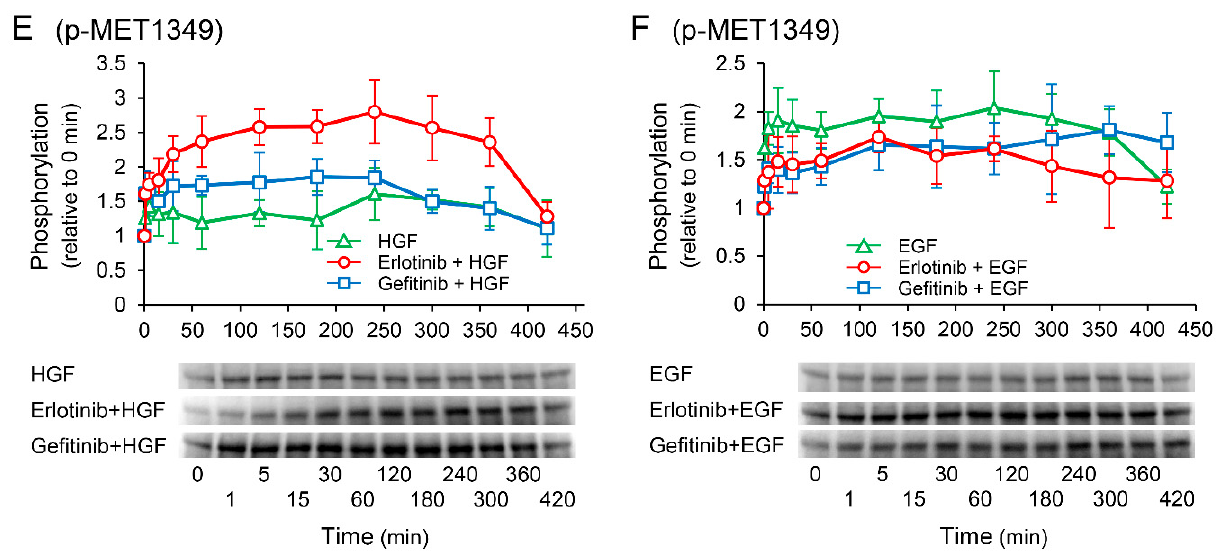
Figure 8. Effects of erlotinib and gefitinib on growth factor-induced phosphorylation of c-Met. HepG2 cells were cultured for 24 h in serum-starved medium. Thereafter, HGF (50 ng/mL) or EGF (50 ng/mL) was added to the medium. Cells were pretreated with erlotinib (5 µM) or gefitinib (1 µM) 15 min before treatment with growth factors. Total protein was collected at the indicated time points. The relative amount of phosphorylated protein in each band was quantified by ImageQuant TL software, and phosphorylation trends at Tyr1003 ( A , B ), Tyr1124/1125 ( C , D ), and Tyr1349 ( E , F ) after treatment with growth factors were plotted on graphs. The intensity of phosphorylation is expressed relative to that at 0 min. Western blot analysis was performed in 3 experiments for 3 different preparations, and representative blots are shown. Each bar represents the mean ± SD.